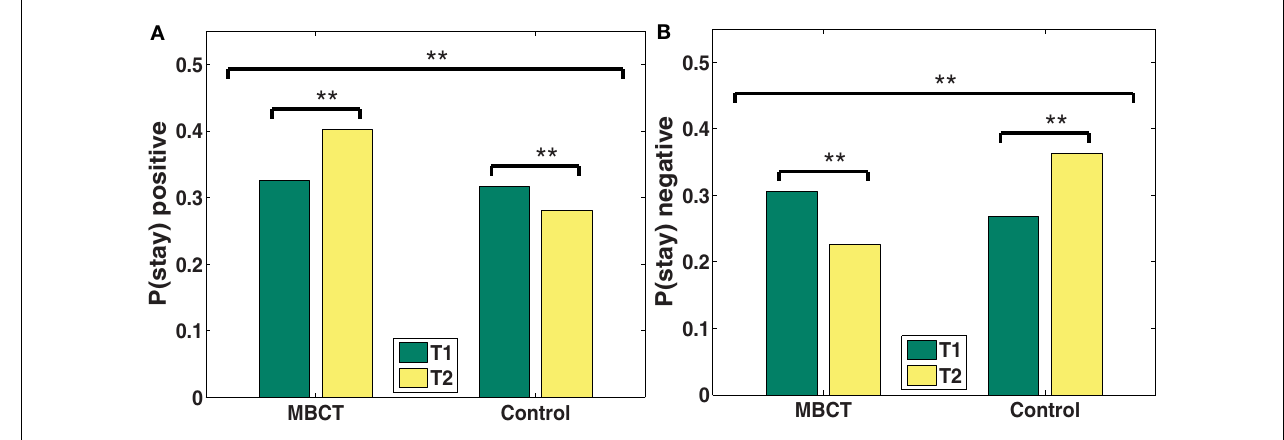
FIGURE 3 | (A,B) Changes in probability of staying within the same category fromT1 toT2 by valence category ( A : positive; B : negative). * p < 0.05, ** p <